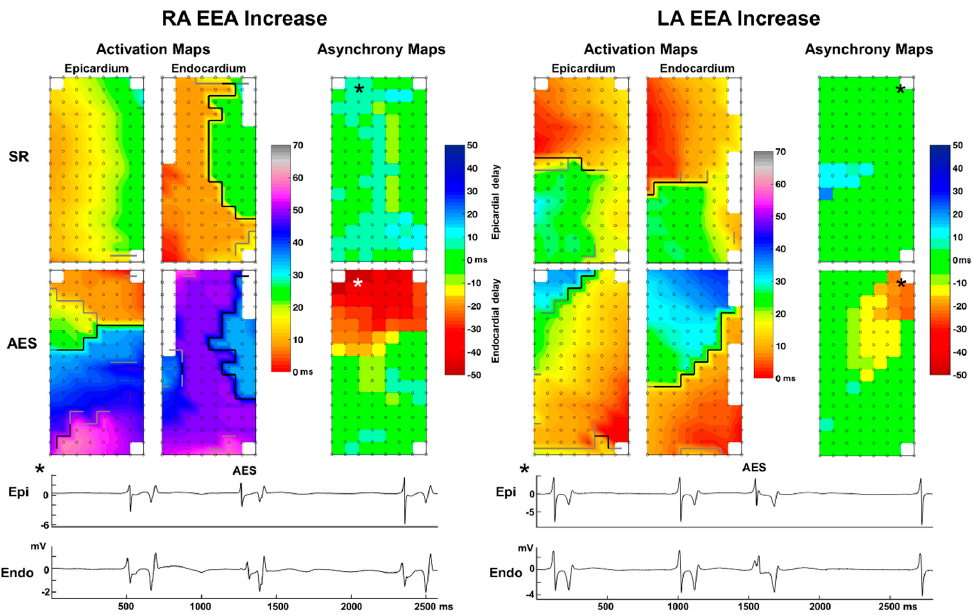
Figure 2. Examples of an increase of endo-epicardial asynchrony (EEA) during atrial extrasystoles (AES) at the right (RA) and left atrium (LA). Color-coded activation maps of epicardial and endocardial local activation times and asynchrony maps are presented for sinus rhythm (SR, top) and atrial extra systole (AES, middle). Grey and black lines represent interelectrode conduction delay and block. Bottom: electrogram examples from the location where EEA increases during the AES